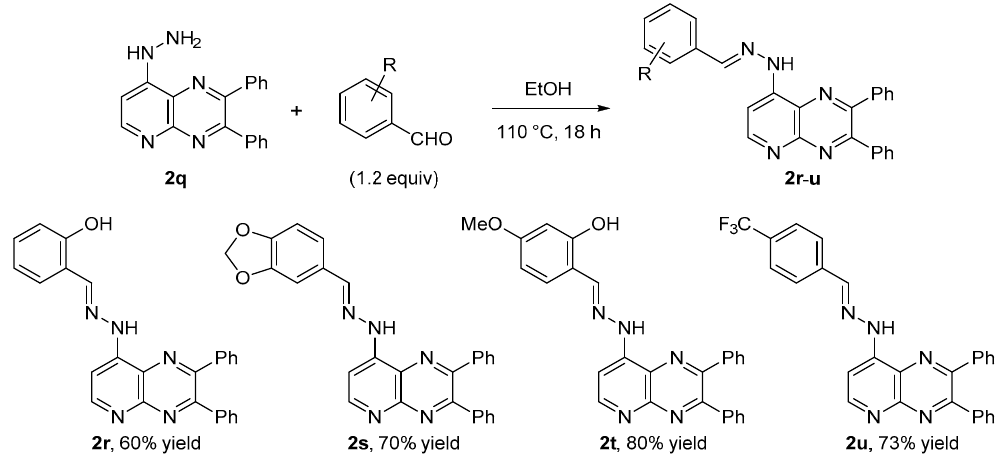
Table 5. Conversion of 8-iodo-2,3-diphenylpyrido[2,3- b ]pyrazine ( 2b-I ) into corresponding amines and hydrazine.